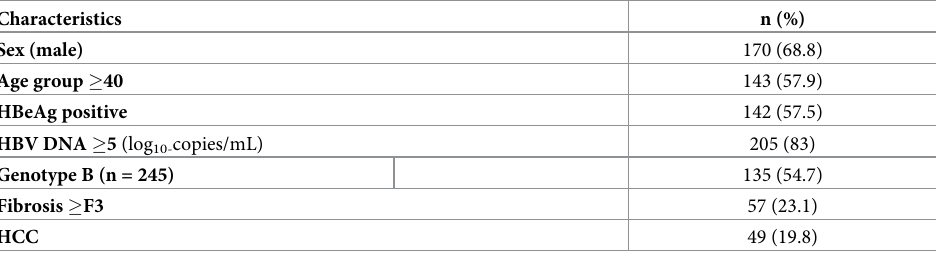
Table 1. Characteristics of the study population (n =